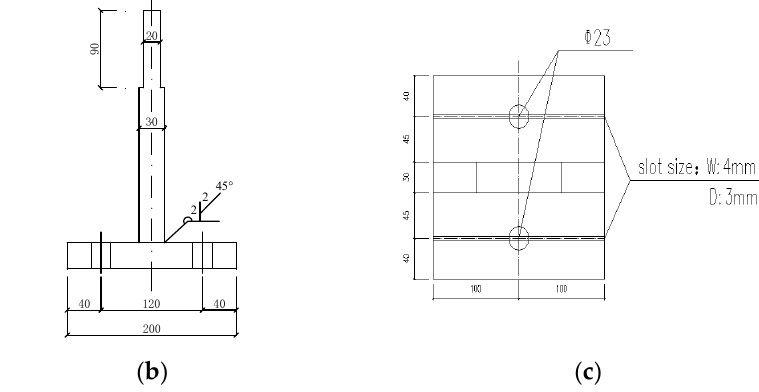
Figure 2. Details of the T ‐ shaped connector (unit: mm). ( a ) Left view. ( b ) Front view. ( c ) Plan view.